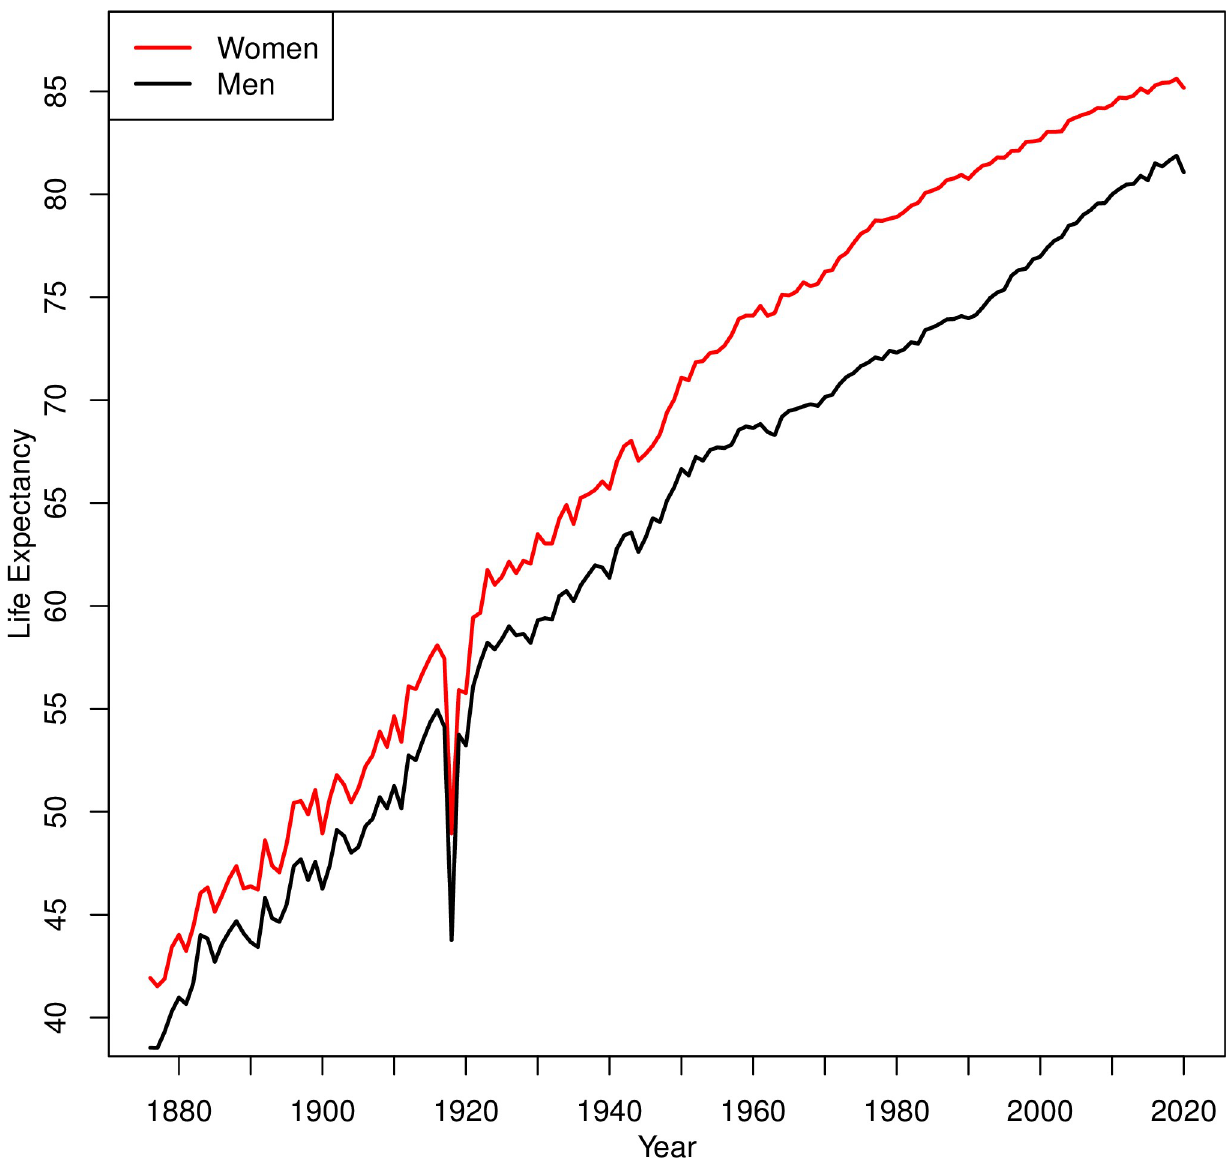
Fig 3. Life expectancy in Switzerland for the period 1876–2020 for men and women (data from the Swiss Federal Statistical Office and the Human Mortality Database).